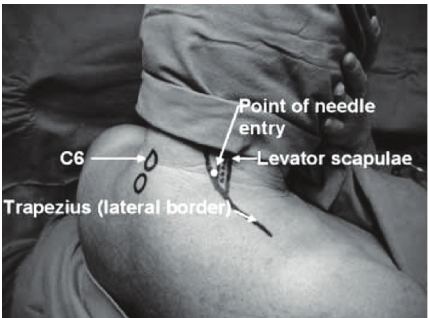
Figure 5: Cervical paravertebral block. Needle entry is at the level of C6, anterolateral to the trapezius muscle and posteromedial to the levator scapulae muscle (Boezaart [2]). (Reprinted with permission from